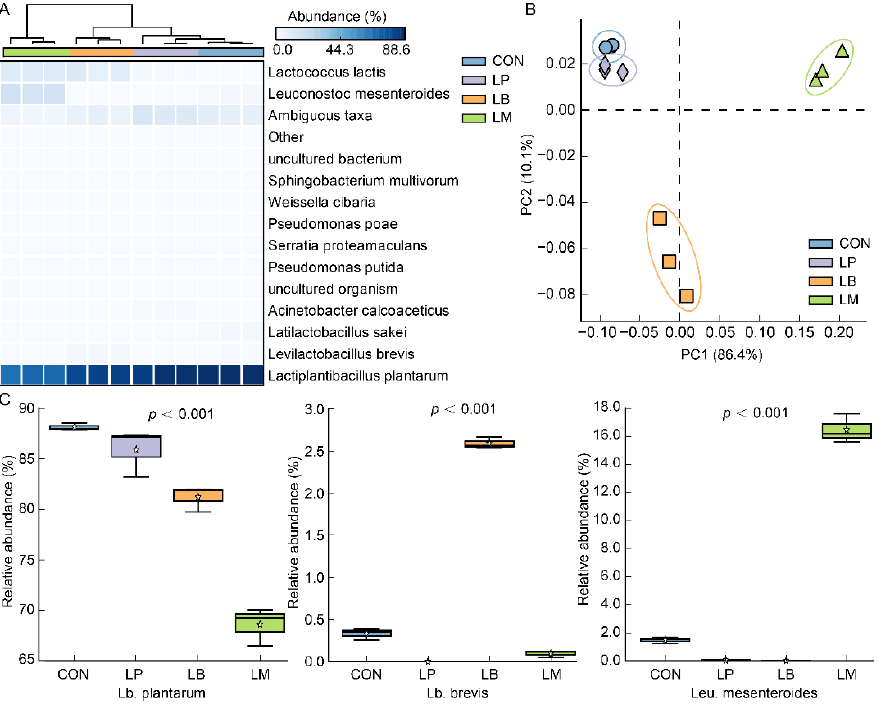
Figure 2. The heatmap ( A ), PCA ( B ), and relative abundance ( C ) of the bacterial community at the species level in Suancai fermented with different autochthonous LABs. species level in Suancai fermented with different autochthonous